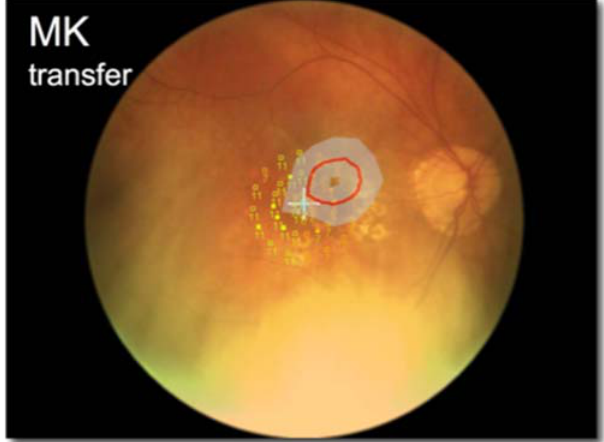
Figure 3. Transferred after image for subject MK. Red line indicates mean scotoma boundary assessed using dynamic after effect. Subject observed the adapting pattern with his left eye which has a dense central scotoma (figure 1) whilst covering the right eye. On a given signal MK moved his hand from his right to his left eye and observed the isoluminant screen. No dense scotoma was identified using microperimetry in the right eye but paracentral areas of relative scotoma were